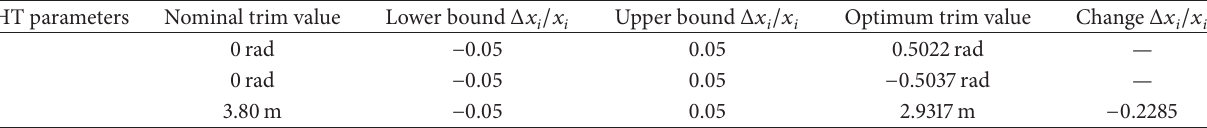
Table 2: MHT parameters, constraints, and optimum points using